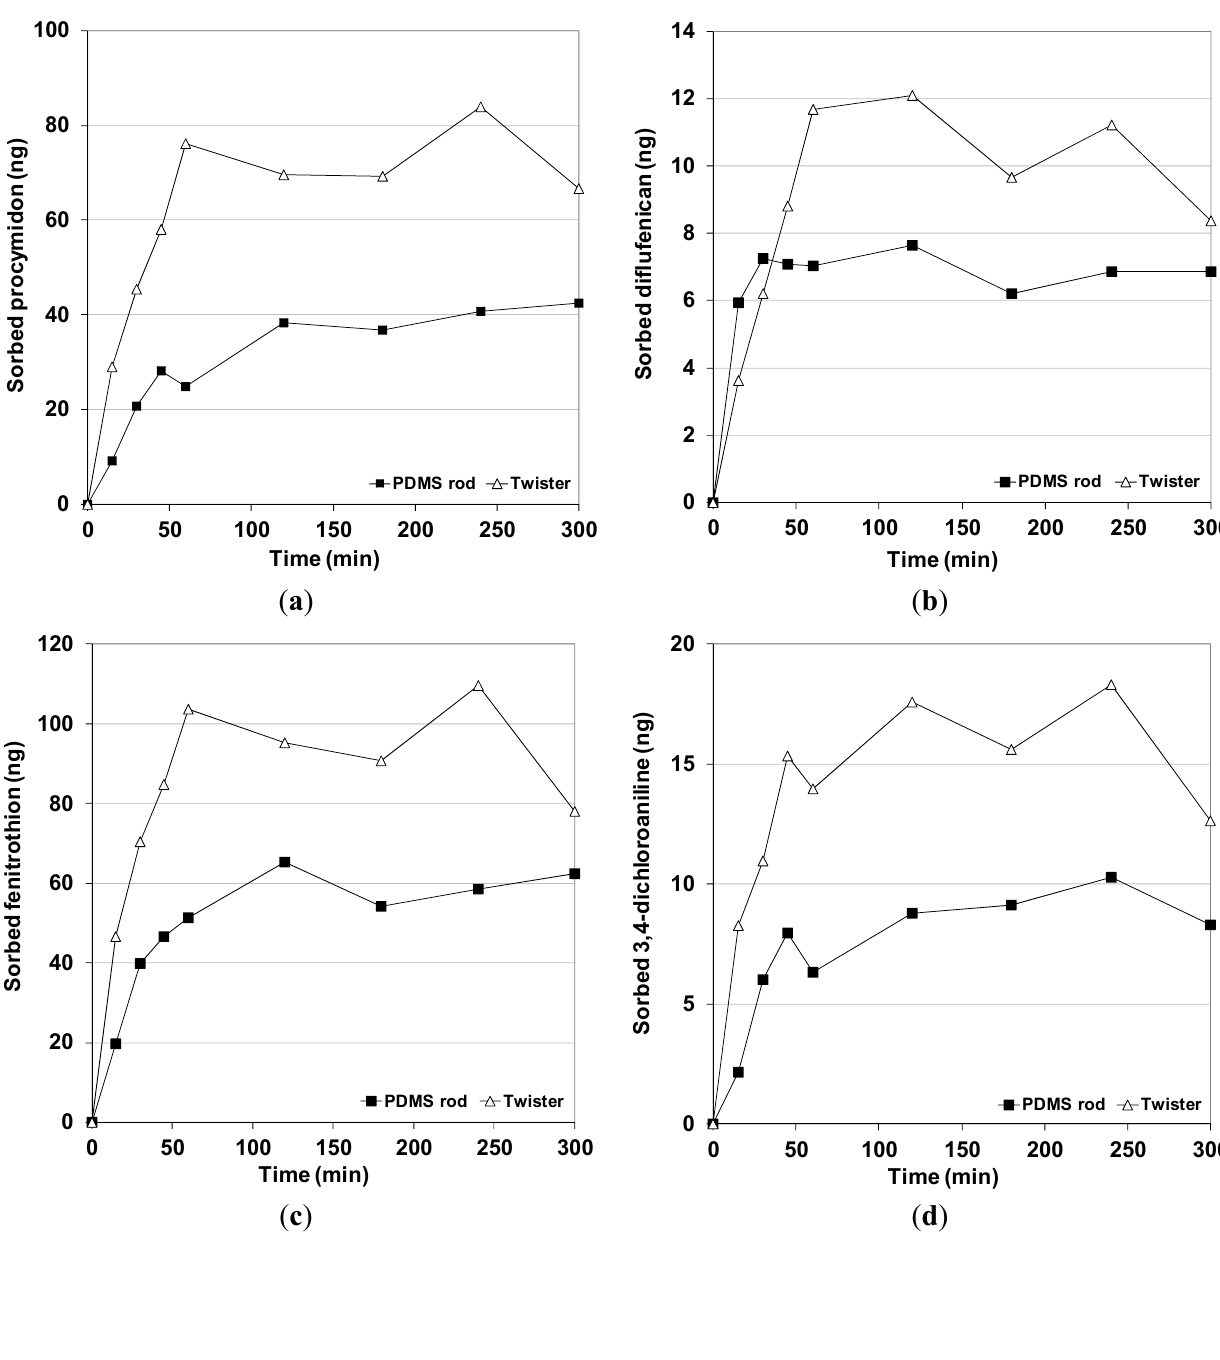
Figure A1. ( a ) Sorption kinetics of procymidon (at 5 μ g L − 1 ); ( b ) diflufenican (at 0.5 μ g L − 1 ); ( c ) fenitrothion (at 5 μ g L − 1 ); ( d ) 3,4-dichloroaniline (at 2.5 μ g L − 1 ); ( e ) chlorpyrifos-methyl (at 2 μ g L − 1 ); and ( f ) spiroxamine (at 0.125 μ g L − 1 ) for PDMS_5 rods and Twisters. Extraction at 700 rpm for maximum 5